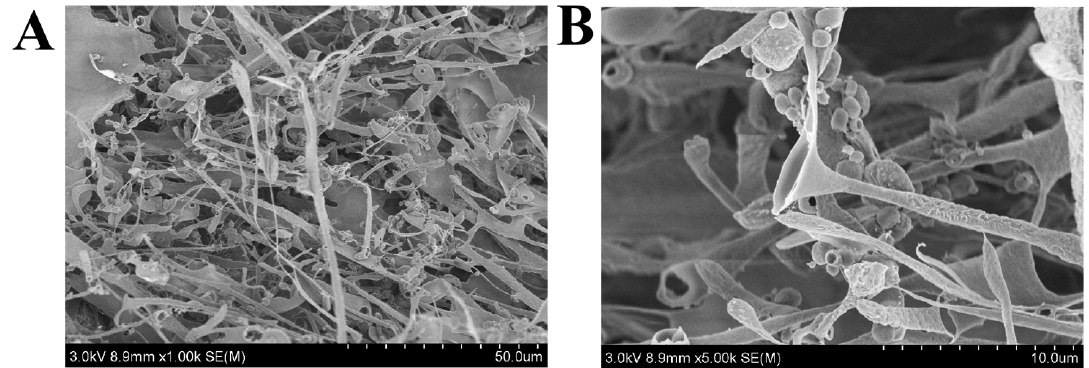
8 of 19 Figure 4. Thermogram curves of the EPS produced by Lpb. plantarum NMGL2. 3.5. Microstructural Analysis of EPS 3.5.1. SEM Analysis Scanning electron microscopy was used to study the surface morphology of macro- molecules that is associated with their physical properties. As shown in Figure 5 under 1000× (Figure 5A) and 5000× (Figure 5B) magnifications, the purified EPS produced by